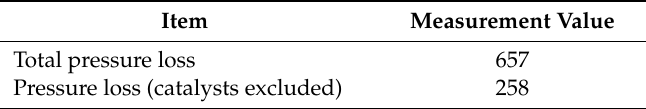
Table A15. Pressure loss in Experiment A5 (Pa).